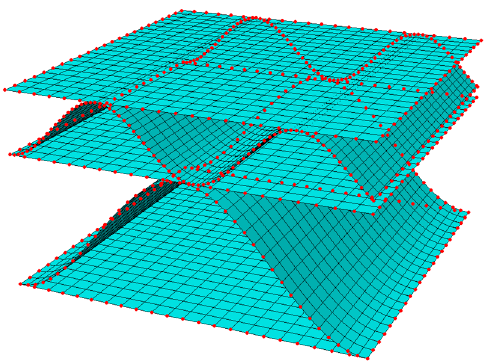
Figure 6. Finite element mesh and external nodes (in red color).